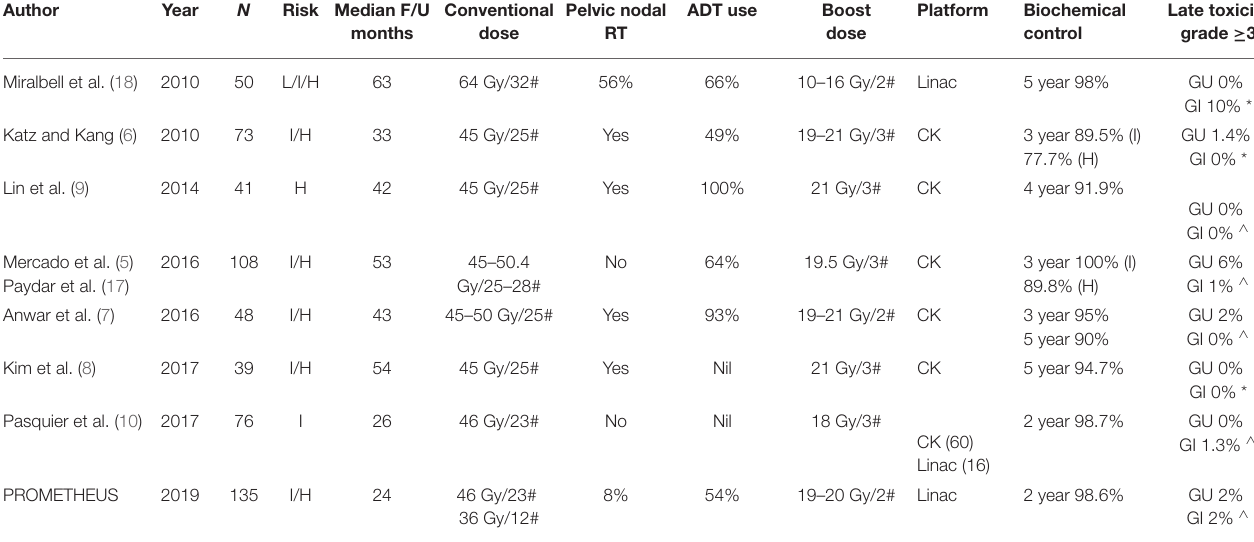
TABLE 3 | Summary of studies evaluating SBRT boost